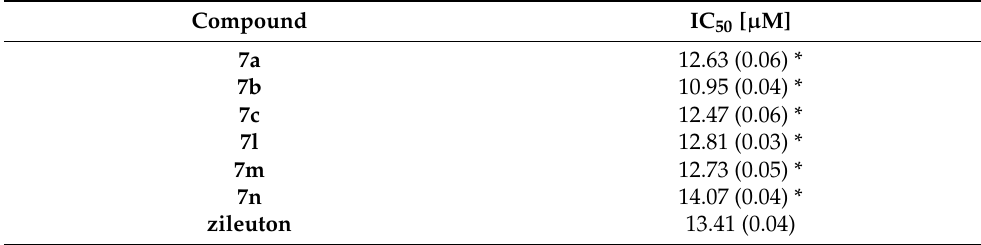
Table 1. IC 50 values calculated for 15-lipoxygenase (15-LOX) enzyme; incubation for 5 min with the tested compounds (mean (SD); n = 3); statistical significance of 15-LOX inhibition calculated with post hoc test compared to the control with zileuton (* p < 0.05).